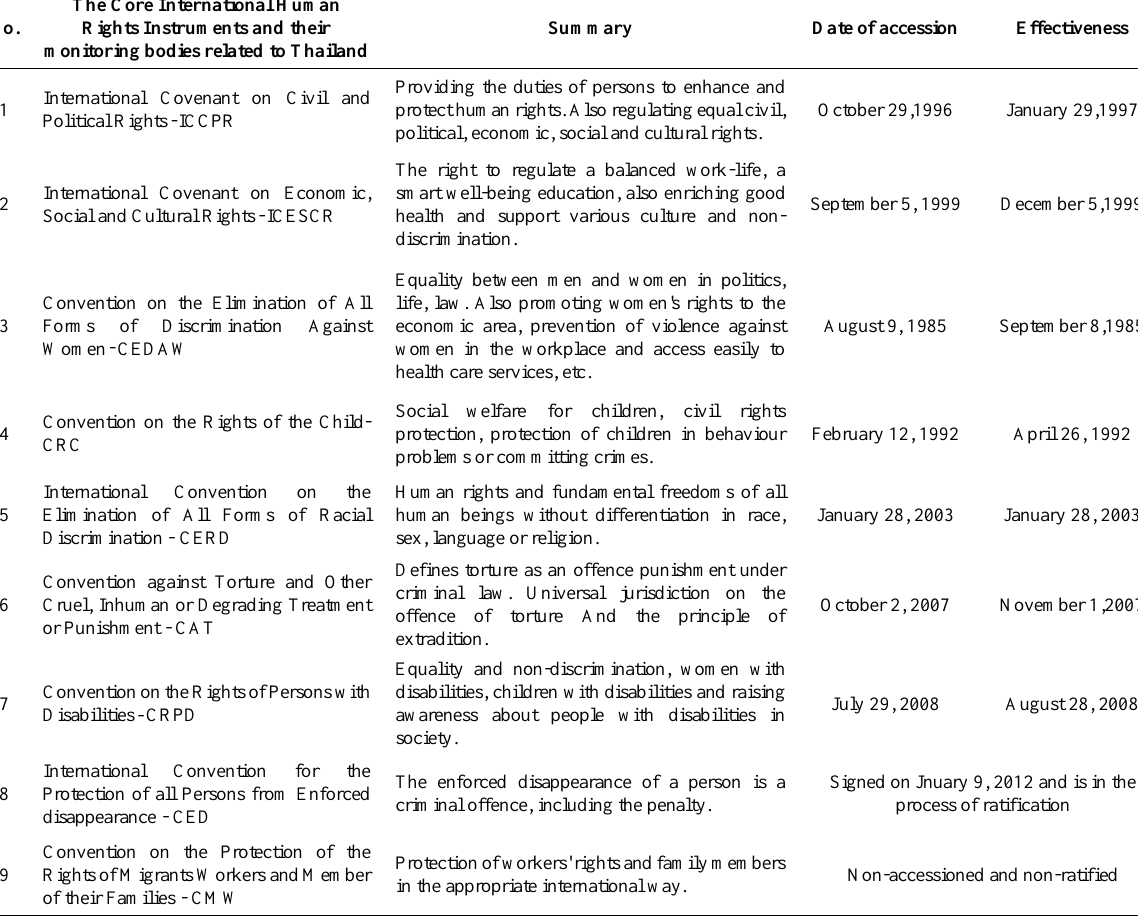
Table 1. The Core International Human Rights Instruments and their monitoring bodies related to